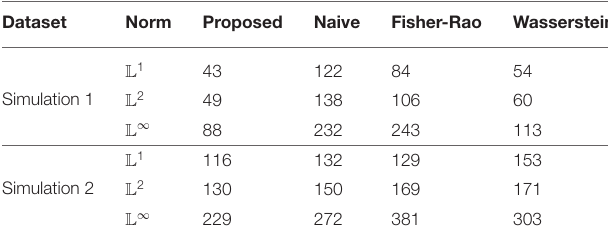
TABLE 2 | Estimation errors for each method in two simulated datasets. Dataset